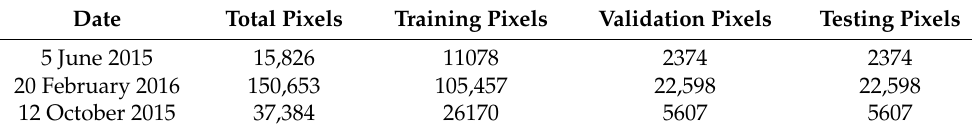
Table 6. Rainy mask subset-night-time.